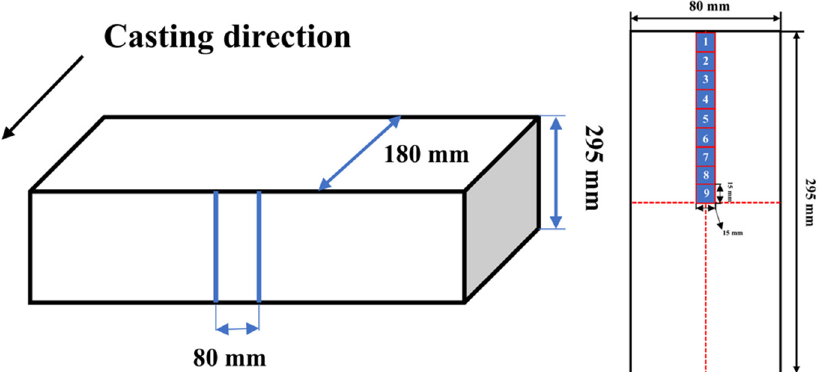
Figure 8. Schematic diagram: Samples for SDAS.